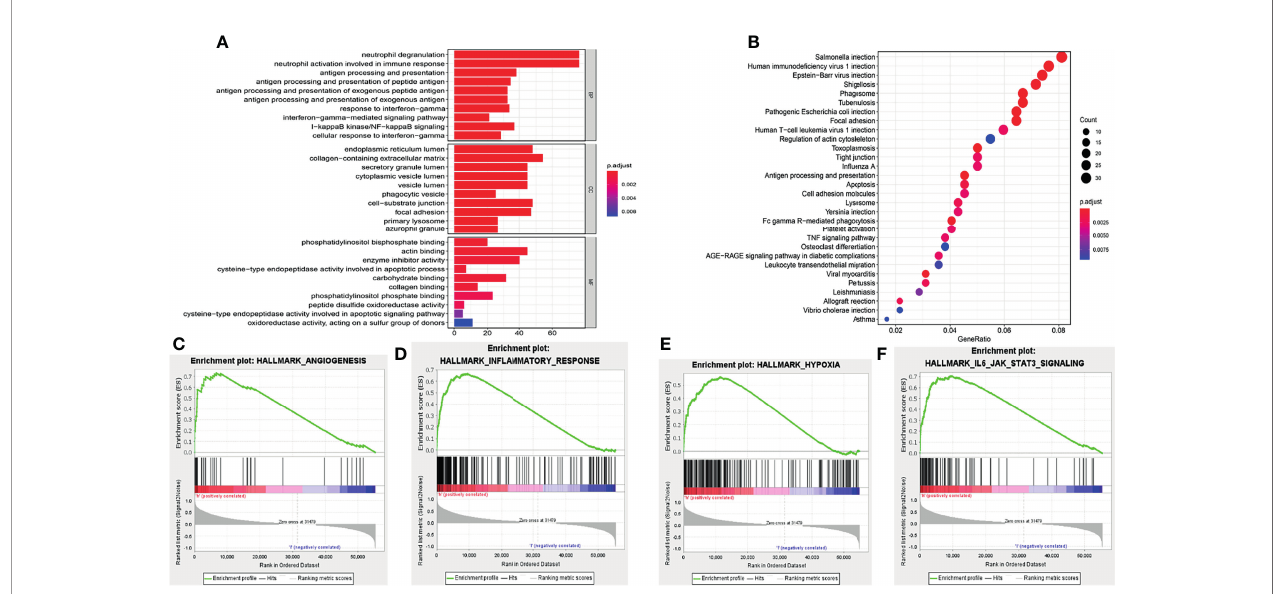
FIGURE 5 | Functional analysis of the risk signature. (A) GO analysis of eleven pyroptosis-related genes. “ BP ” , “ CC ” and “ MF ” represent “ biological process ” , “ cellular component ” and “ molecular function ” , respectively. (B) KEGG analysis of eleven pyroptosis-related genes. (C – F) GSEA showed that genes with higher expression in the high-risk group enriched the features of malignant